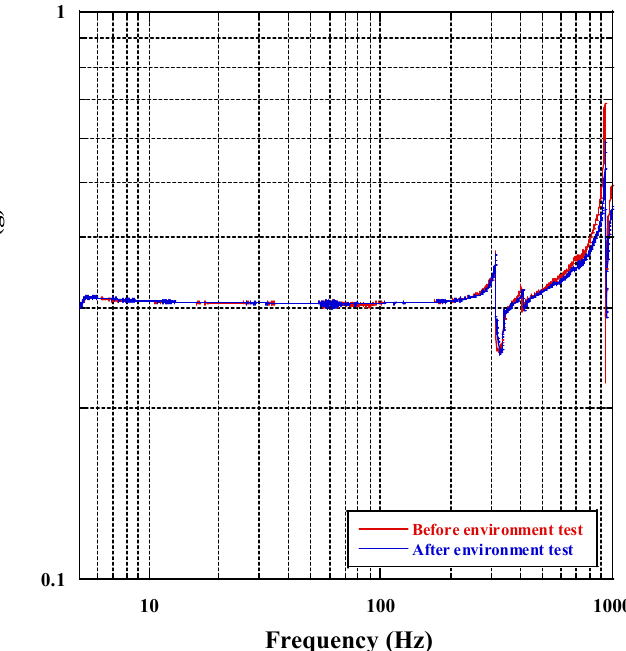
Figure 12. Low level Sine Sweep results.